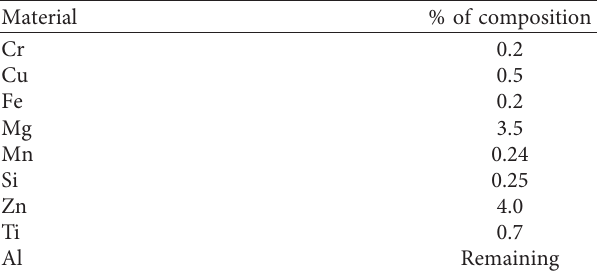
Table 3: Wear test process parameters and their